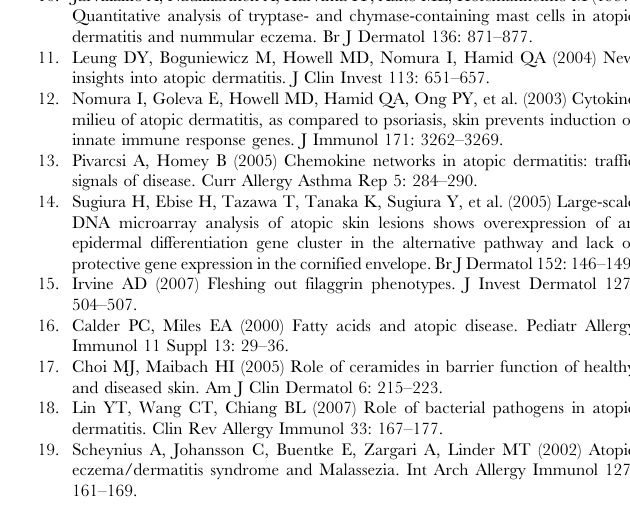
Table S4 Overview of skin biopsy samples that were used in the SAM approach to identify differentially expressed genes in AE and healthy skin. Shown are six groups of samples representing skin from atopic eczema patients (SAM group 1-3: AE-L, AE-M, AE-P) and healthy control individuals (SAM group 4-6: H-N, H-M, H- P). Corresponding microarray slide name are given for each sample using the same nomenclature as is used in the Stanford Microarray Database